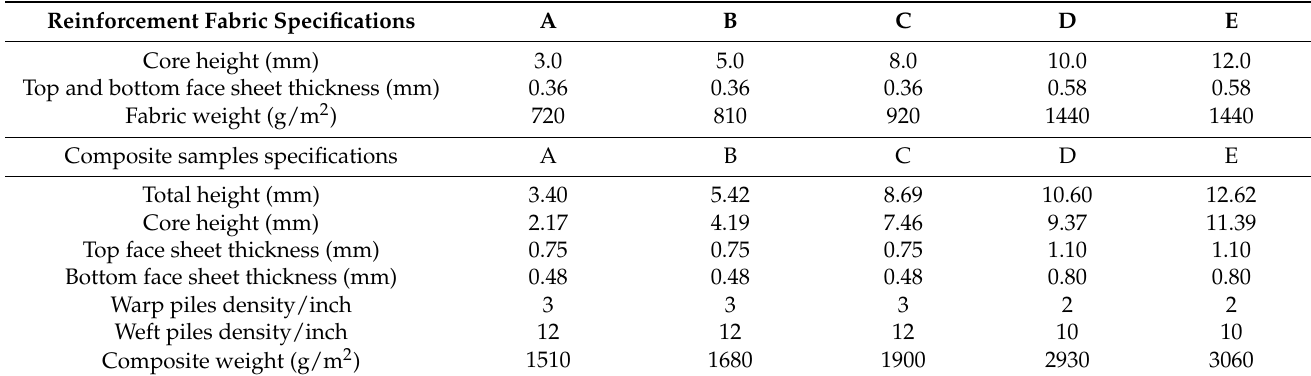
Table 1. Specifications of 3D integrated woven spacer reinforcement fabrics and sandwich compo- site samples.